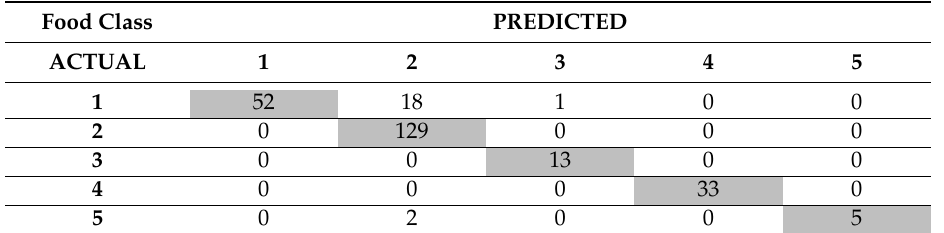
Table 6. The confusion matrix. Each column represents the objects in a predicted class, while each row represents the objects in an actual